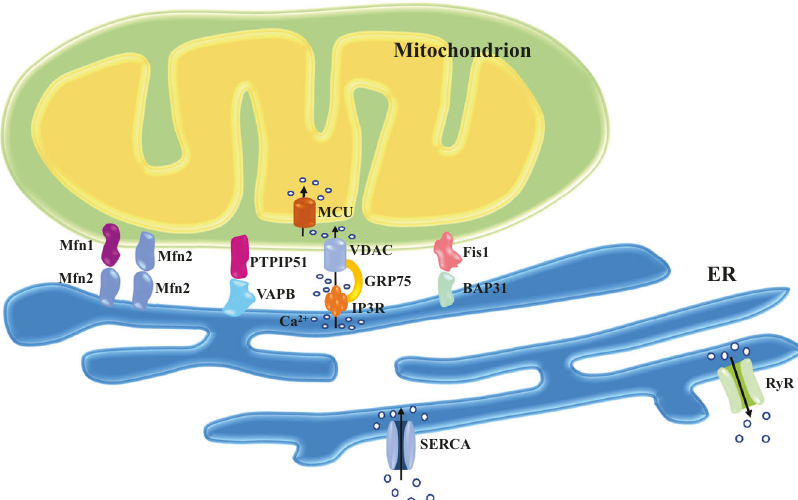
Fig. 1 Main tethering proteins involved in the maintenance of MAMs. Mitochondria are connected to ER by protein complexes. ER-resident Mfn2 forms hetero- or homodimers with Mfn1/2 in OMM. The ER protein VAPB interacts with the mitochondrial protein PTPIP51. The ER- localized IP3R partners with the mitochondrial protein VDAC through GRP75. BAP31 resided in the ER is anchored to the OMM-localized Fis1. SERCA is the main pump responsible for Ca 2 + uptake in the ER. RyR releases Ca 2 + from ER into the cytoplasm. The IMM-resident MCU is the predominant pathway transferring Ca 2 + into mitochondrial matrix. Abbreviations: BAP31, B-cell receptor-associated protein 31; ER, endoplasmic reticulum; Fis1, fi ssion protein 1 homolog; GRP75, glucose-regulated protein 75; IMM, inner mitochondrial membrane; IP3R, inositol 1,4,5-triphosphate receptors; MAMs, mitochondria-associated membranes; MCU, mitochondrial Ca 2 + uniporter; Mfn1/2, mitofusin-1 and -2; OMM, outer mitochondrial membrane; PTPIP51, protein tyrosine phosphatase-interacting protein-51; RyR, ryanodine receptor; SERCA, sarco(endo)plasmic reticulum calcium-ATPases; VAPB, vesicle-associated membrane protein-associated protein-B; VDAC, voltage-dependent anion